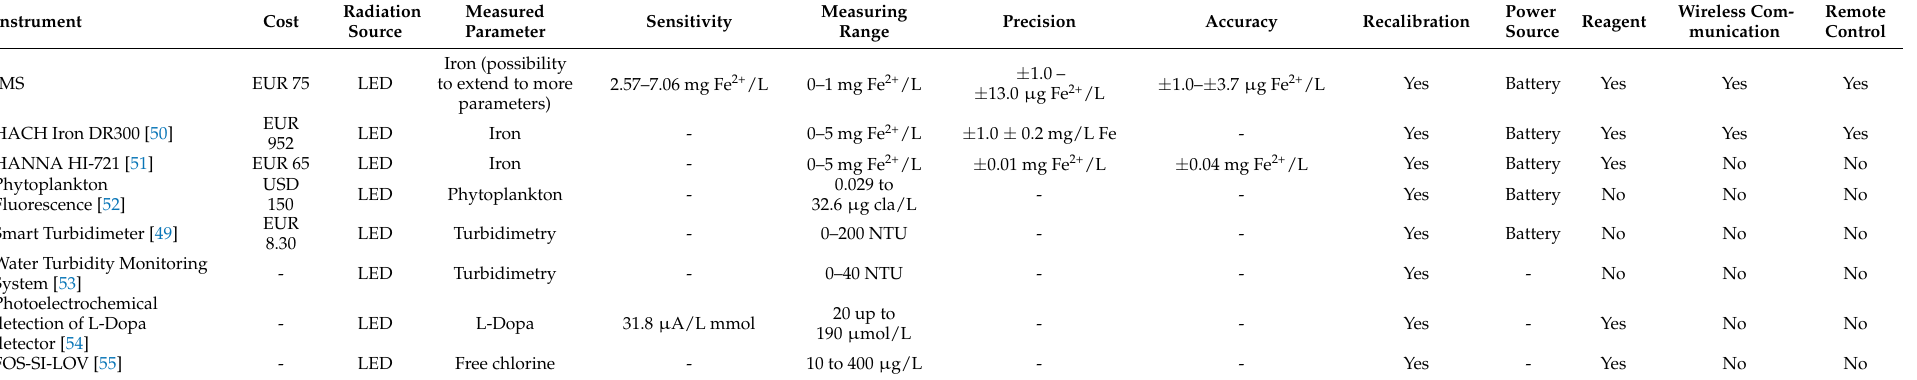
Table 8. Summary of the different commercial solutions and scientific publications dedicated to determination of water quality